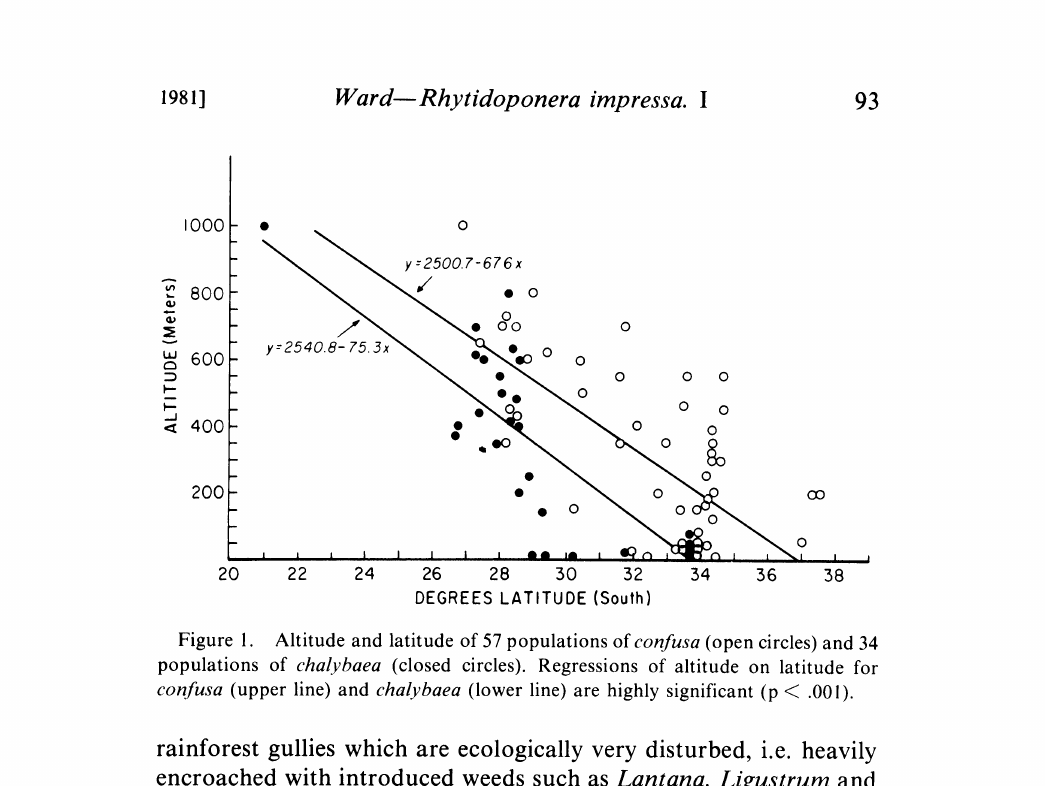
Figure I. Altitude and latitude of 57 populations of confusa (open circles) and 34 populations of chalybaea (closed circles). Regressions of altitude on latitude for confusa (upper line) and chalybaea (lower line) are highly significant (p < .001). rainforest gullies which are ecologically very disturbed, i.e. heavily encroached with introduced weeds such as Lantana, Ligustrum and Trades can